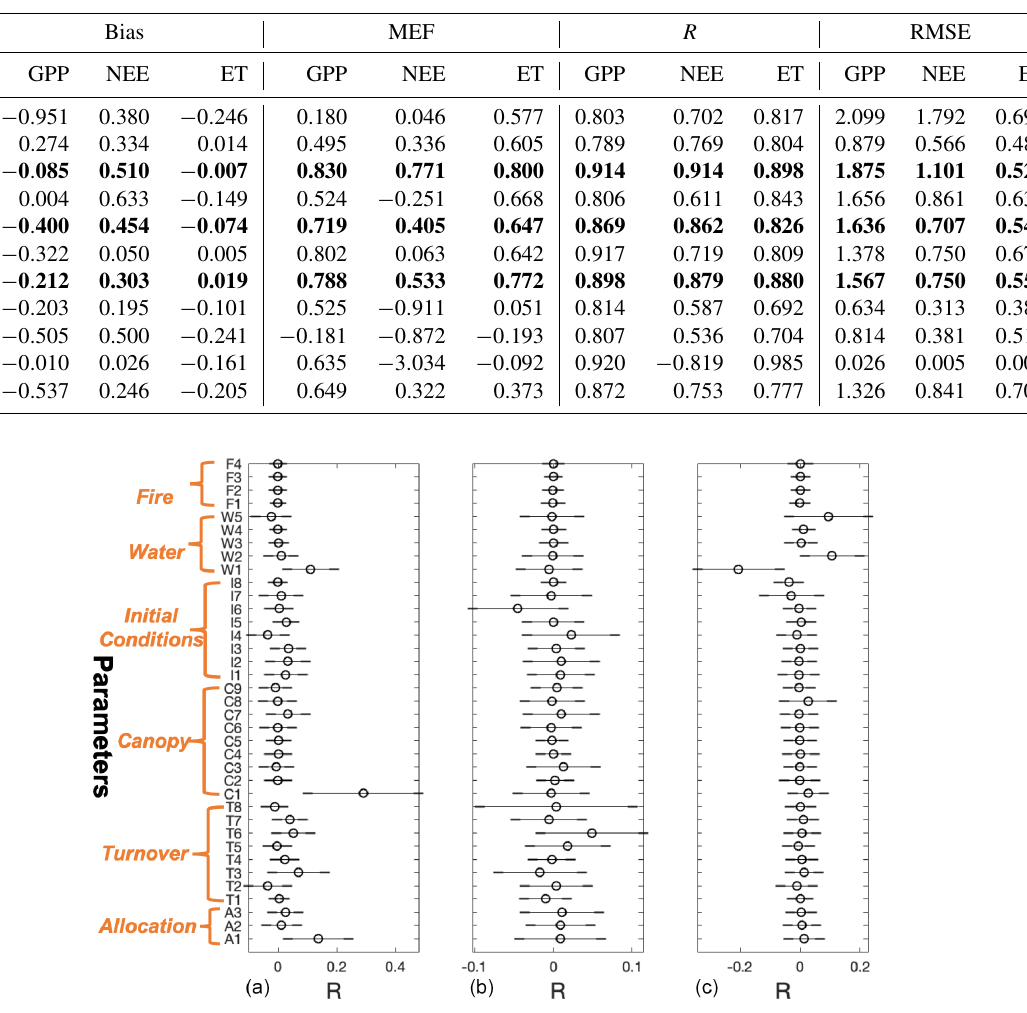
Figure 5. Correlations between the site-level model parameters and residuals of GPP (left column), NEE (central column), and ET (right column) over all sites in the prediction window. Parameters are described in Table